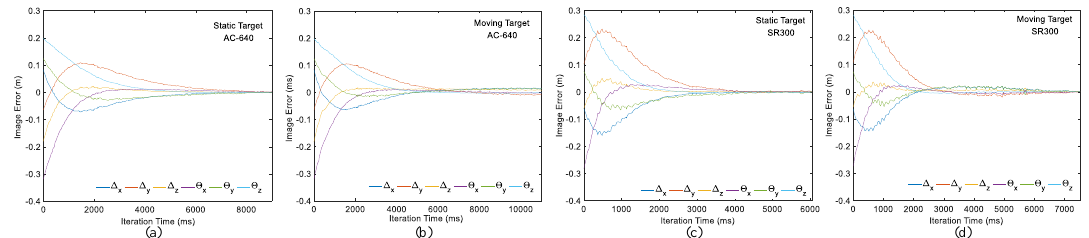
Figure 14. Image changes of the robot arm under planar and RGB-D cameras. ( a , b ) Represents the variation process of the robotic arm’s static and moving target matching error under the planar camera algorithm; ( c , d ) represents the variation process of the robotic arm’s static target and moving matching error under the proposed camera algorithm.